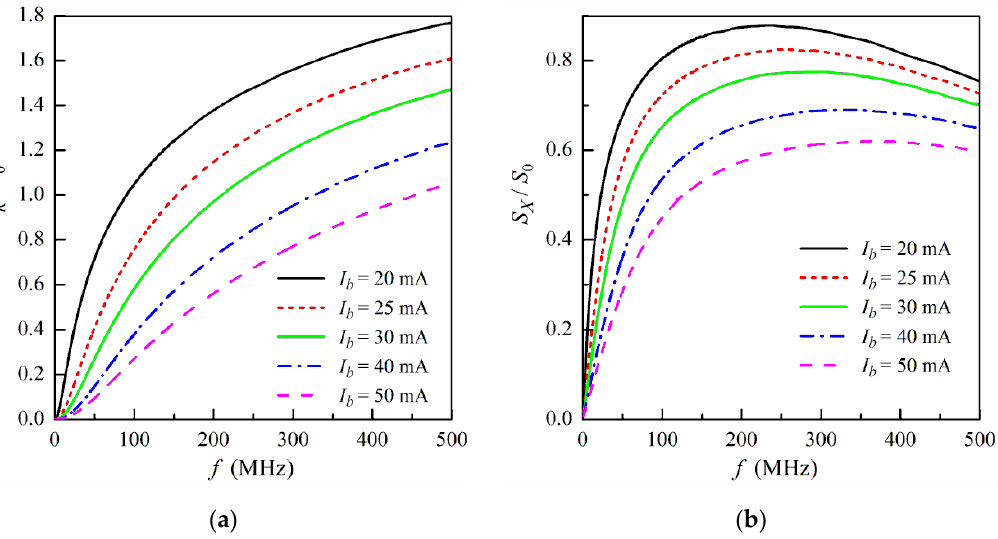
Figure 5. The field sensitivity of the real part S R ( a ) and imaginary part S X ( b ) of the ODMI as a function of the frequency f for different values of the bias current I b . Other parameters used for calculations are the same as in Figure 3. The values of S R and S X are reduced to the characteristic field sensitivity S 0 = Z 0 / H a ,2 .